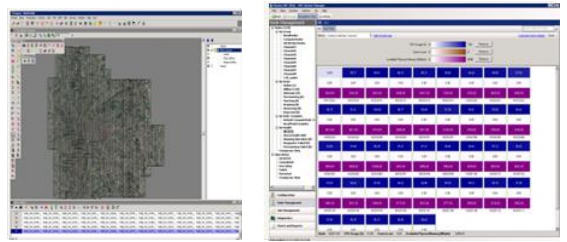
Figure 4. Aerial block and cpu load on a computer cluster